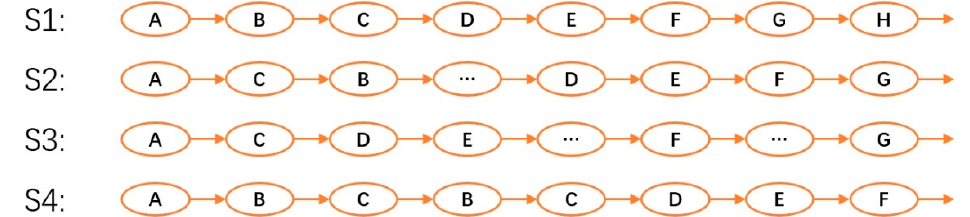
Figure 1. The illustration of the real intrusion sessions. S1, S2, and S3 are three intrusion sessions; A-H is intrusion actions that composed an intrusion scenario; S1 denotes the original session state; S2 is disordered and some irrelevant actions engaged; B is lost in S3; B-C in S4 is repeated due to the intrusion detection system (IDS).